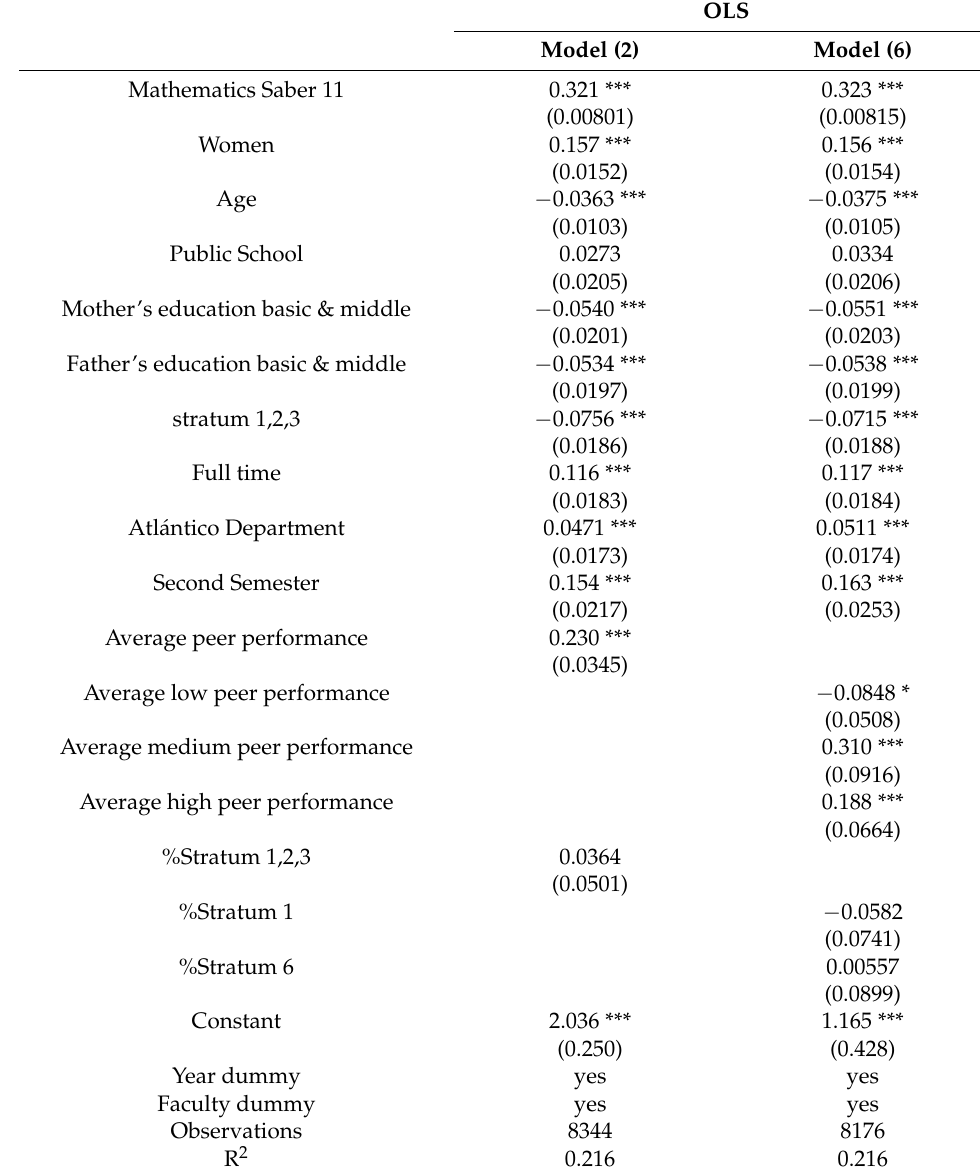
Table 3. Peer effects on academic performance in Calculus